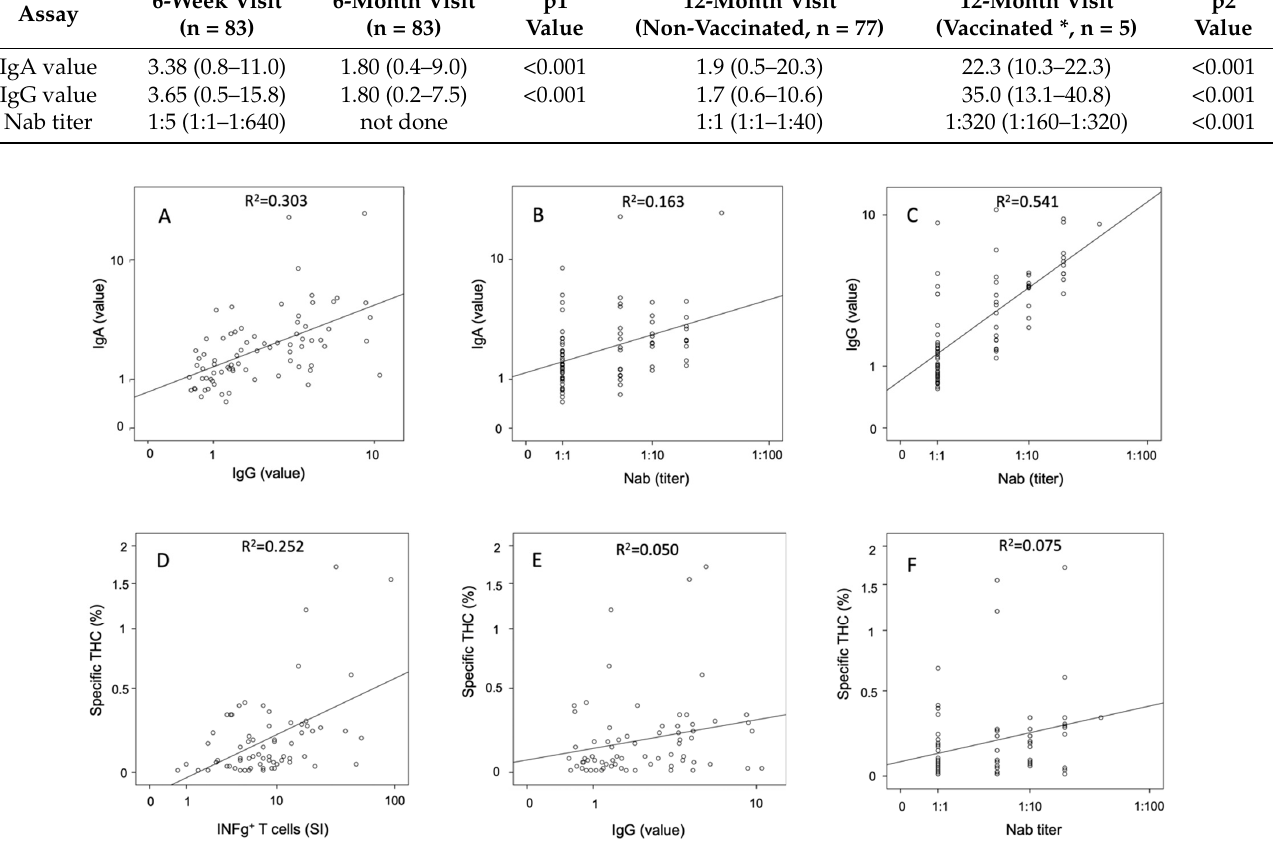
Figure 5. Correlation analyses of humoral and cellular immunity assays in non-vaccinated participants at 12-months follow-up: ( A ) IgG value vs. IgA value; ( B ) titer of Nab vs. IgA value; ( C ) titer of Nab vs. IgG value; ( D ) INFg + T-cells vs. specific THC; ( E ) IgG value vs. specific THC; ( F ) titer of Nab vs. specific THC; Nab, neutralizing antibody; THC, T-helper cells; SI, stimulation index.